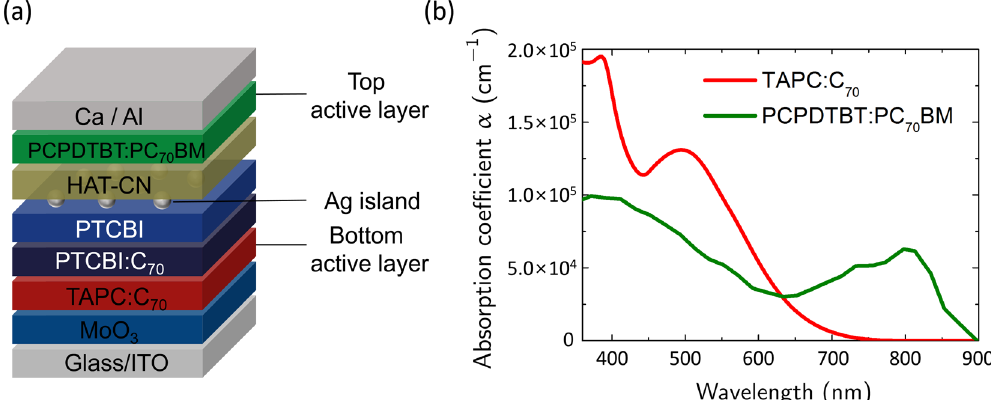
Figure 1. Device structure of transfer-fabricated tandem cells and absorption coefficients of active layers. ( a ) Device structure of a transfer-fabricated tandem cell whose top and bottom subcells have active layers composed of PCPDTBT:PC 70 BM and TAPC:C 70 ( b ) Absorption coefficients of PCPDTBT:PC 70 BM (green) and TAPC:C 70 (red) determined by spectroscopic